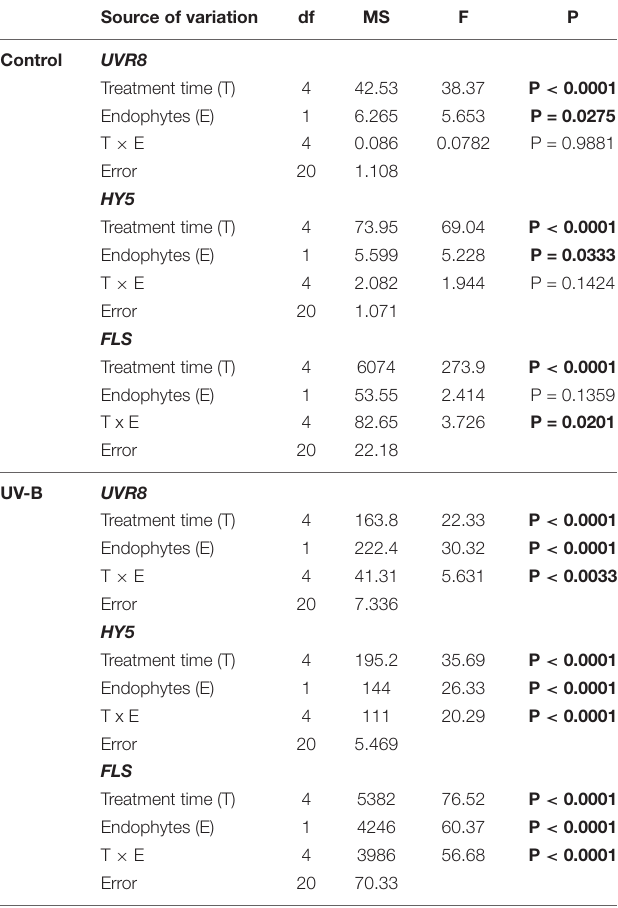
TABLE 3 | Results of factorial ANOVAs evaluating the interactive effects of endophytes presence (E) and different treatment times for (control: without radiation UV-B radiation, UV-B: 46 µ mol m − 2 s − 1 ) for relative level of expression of genes responding to UV-B by qPCR in the leaf of Colobanthus quitensis